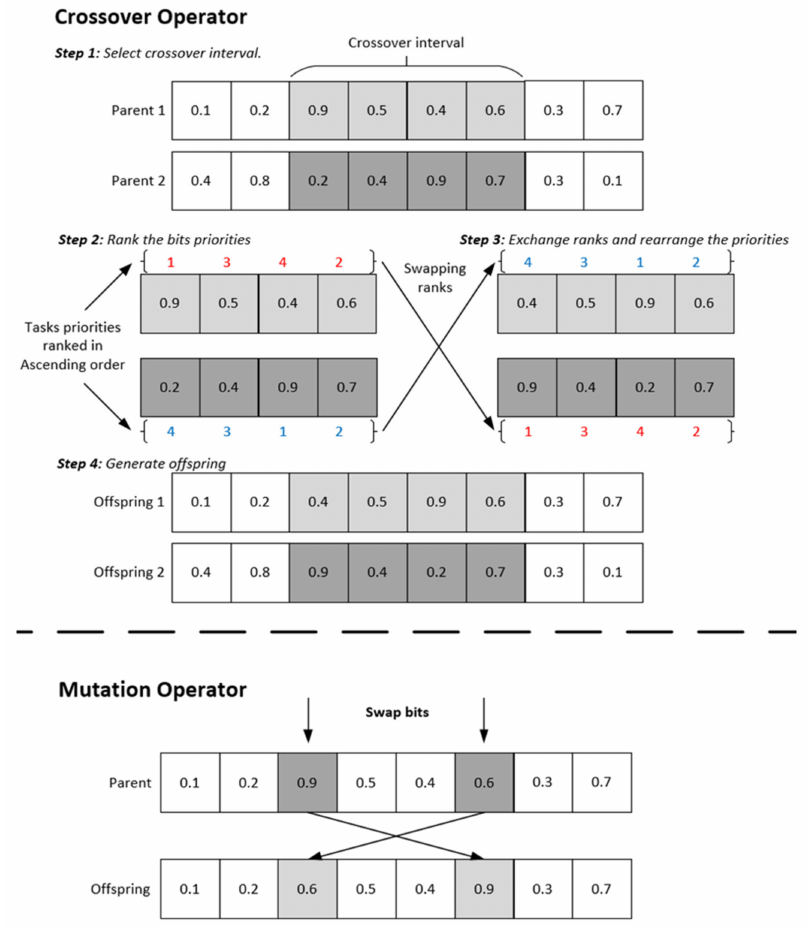
Figure 3. Genetic